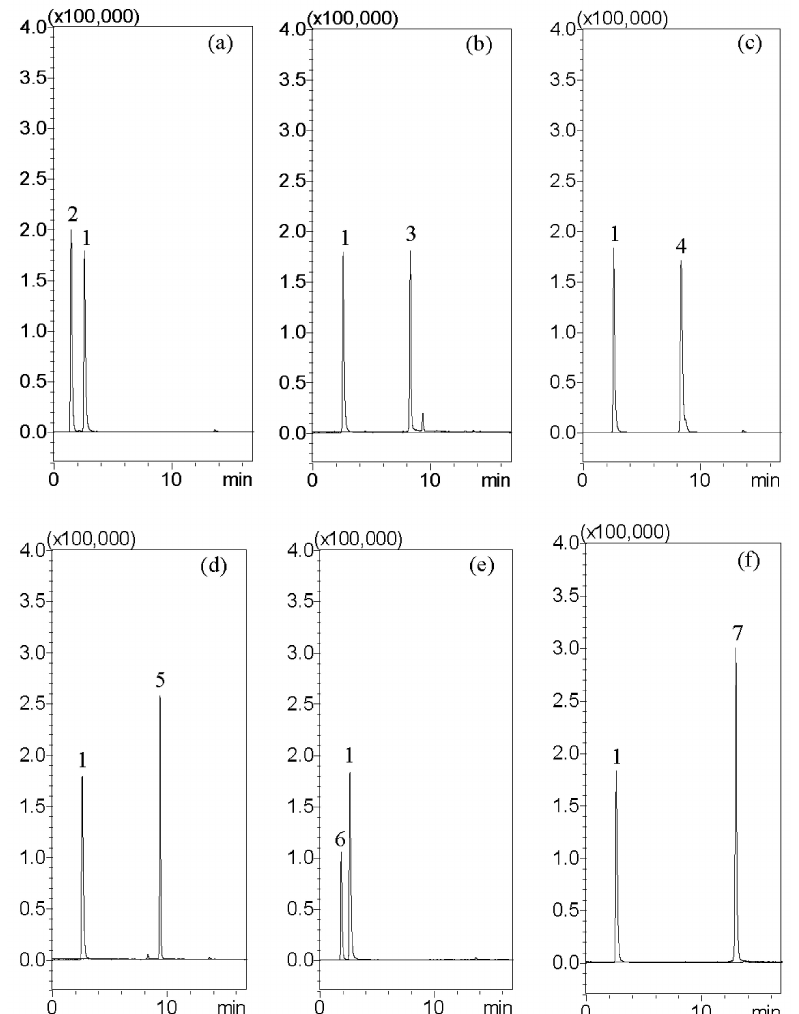
Figure 2. Typical multiple reaction monitoring (MRM) chromatograms of analytes: ( a ) peak two: guanosine (250 ng/mL); ( b ) peak three: atractylenolide III (50 ng/mL); ( c ) peak four: glycyrrhizic acid (1000 ng/mL); ( d ) peak five: dehydrocostus lactone (50 ng/mL); ( e ) peak six: hesperidin (1000 ng/mL); and ( f ) peak seven: oleanolic acid (1000 ng/mL). Peak one: the internal standard is carvedilol (10